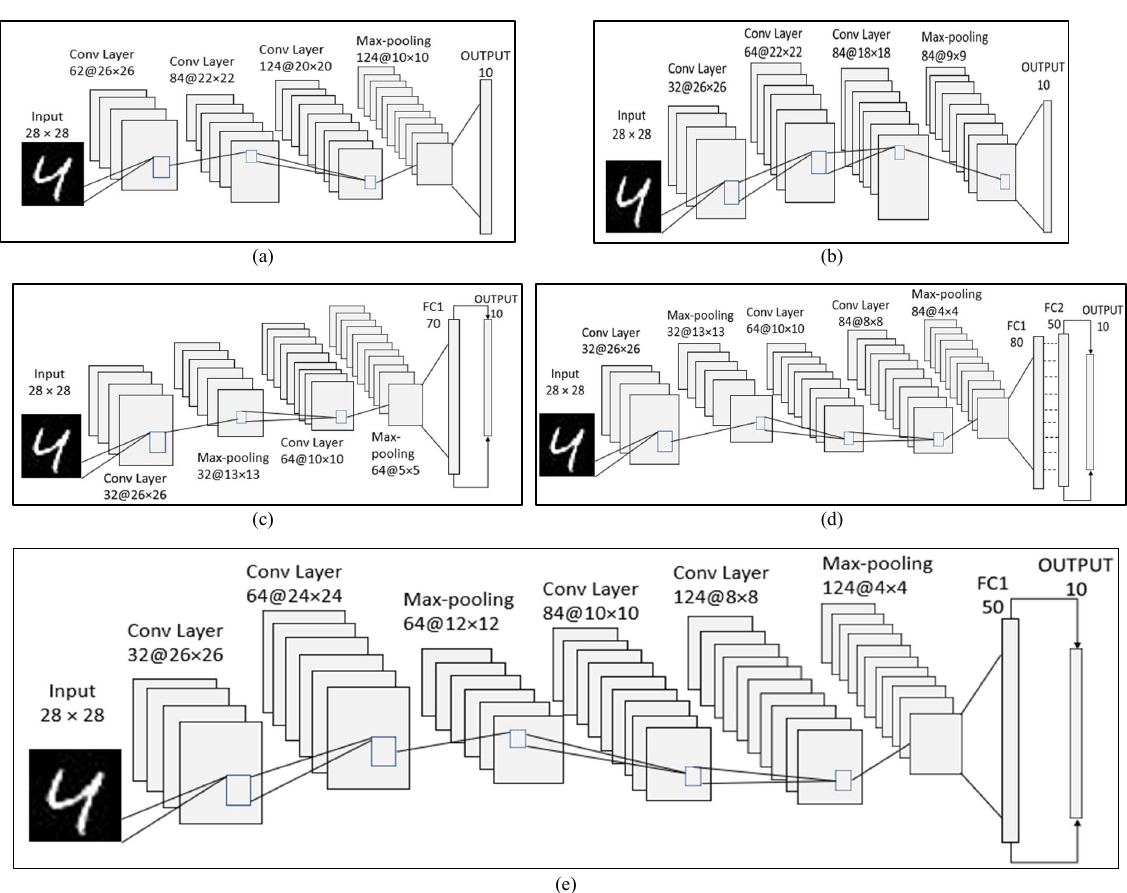
Fig. 5 The proposed five CNN architectures for handwritten digit classification: (a) Architecture 1 (b) Architecture 2 (c) Architecture 3 (d) Architecture 4 (e) Architecture 5 Here, Fig. 5(a) is architecture 1, where the network consists of three consecutive convolutional layers, one pooling layer and finally output layer. Fig. 5(b) has the same structure as Fig. 5(a) but the main difference is the filter size and the number of each layer. Fig. 5(c) consists of two convolutional layers, two pooling layers and two fully connected layers, where the final FC layer is the output layer. Fig. 5(d) consists of three convolutional layers, two pooling layers and three fully connected layers. The last CNN architecture of Fig. 5(e) consists of four convolutional layers, two pooling layers and two fully connected layers. The 1 st convolutional layer used 32 filters, the 2 nd convolutional layer used 64 filters, the 3 rd convolutional layer employed 84 filters and the last convolutional layer used 124 filters. Different numbers of FC layers and max-pooling layers were used in the models to observe the